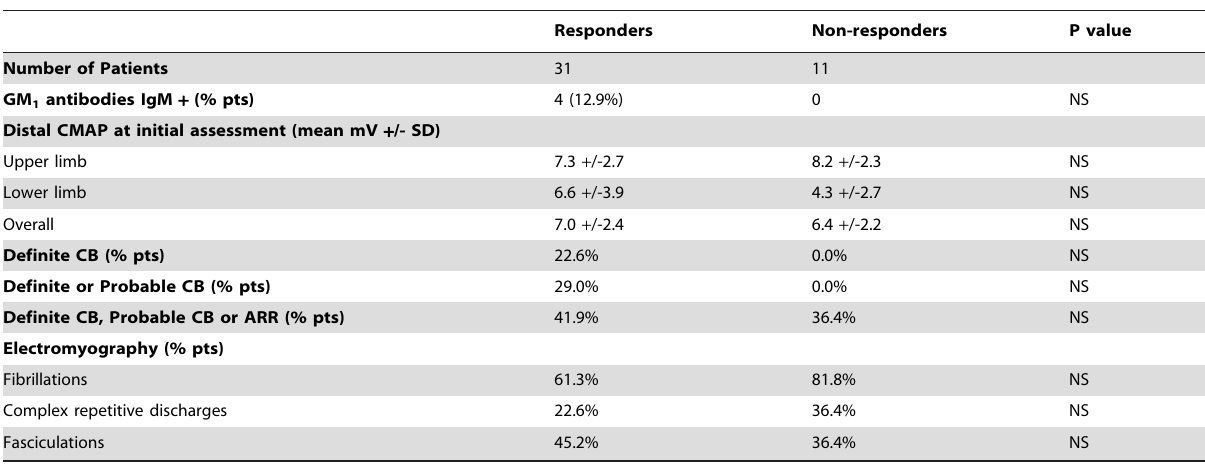
Table 2. Neurophysiological Characteristics.